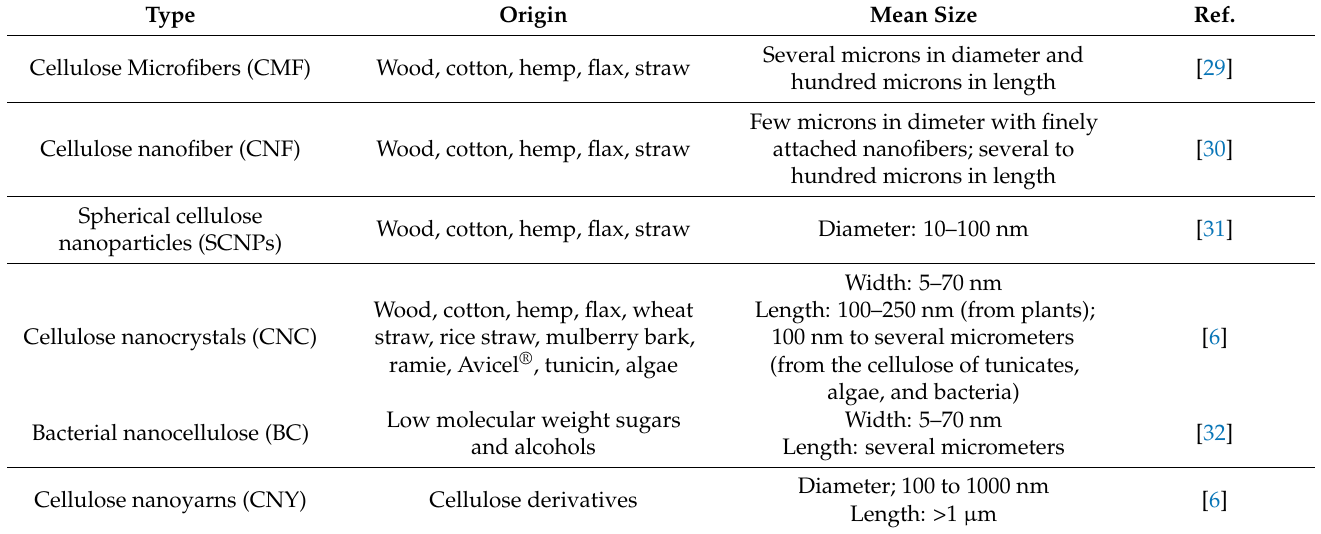
Table 1. Classification of nanocellulose materials according to their morphology, origin, and mean